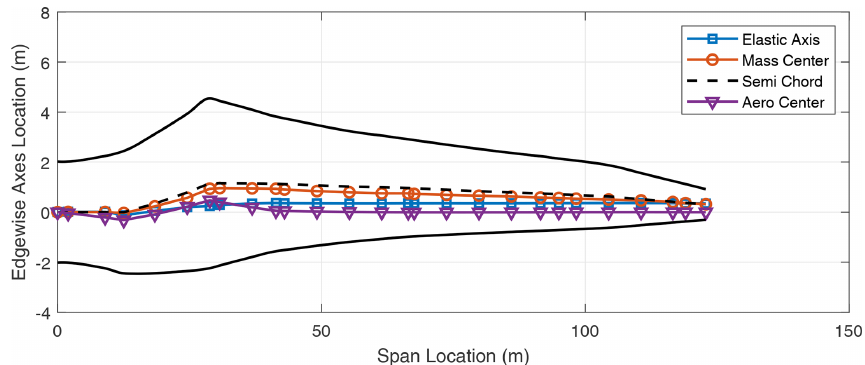
Figure A11. Planform for the SUMR13B turbine blade.